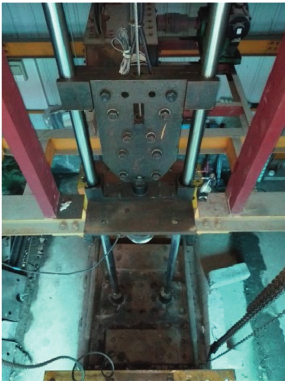
Figure 7: Horizontal traction impact